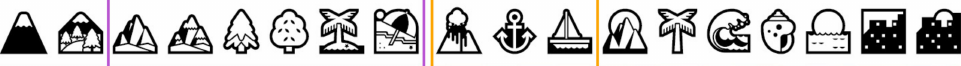
Figure 9. Emojis attributed as location-specific, selected from sunrise- (purple) and sunset-typical (orange) emojis of Italy (left part of each box: typical only for Italy; right part: typical on global and Italian level).